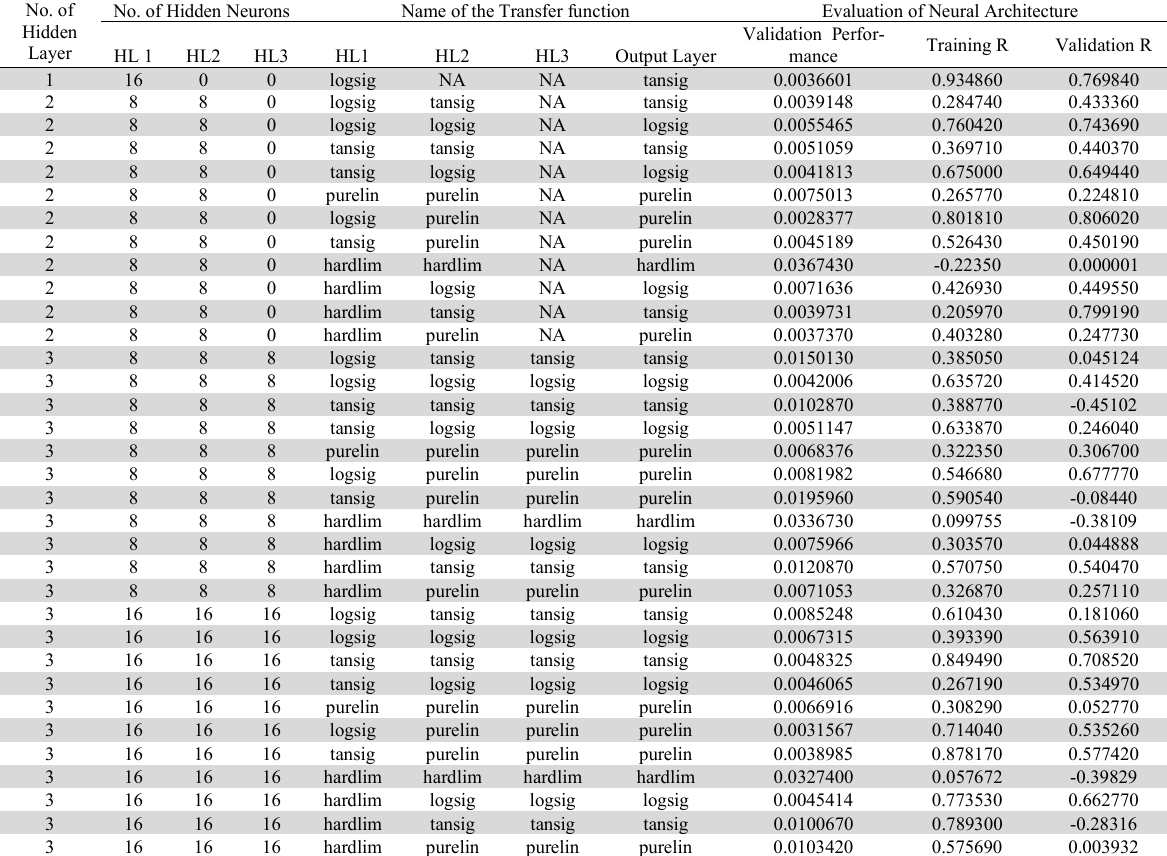
FFNA modelling of Reliability